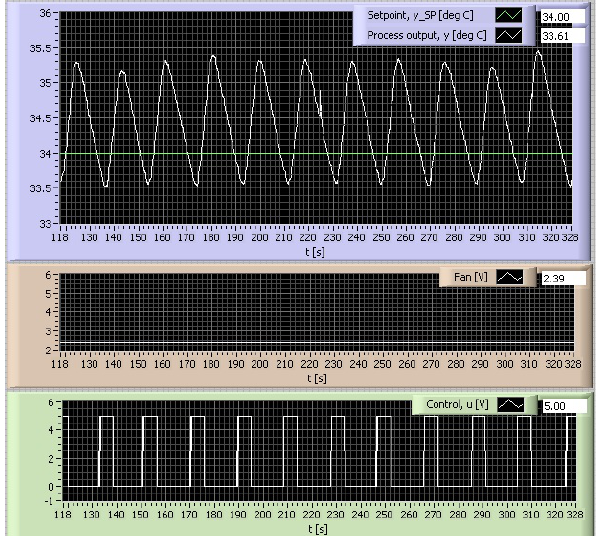
Figure 14: Relay-tuning method: Responses in the con- trol system with relay controller.